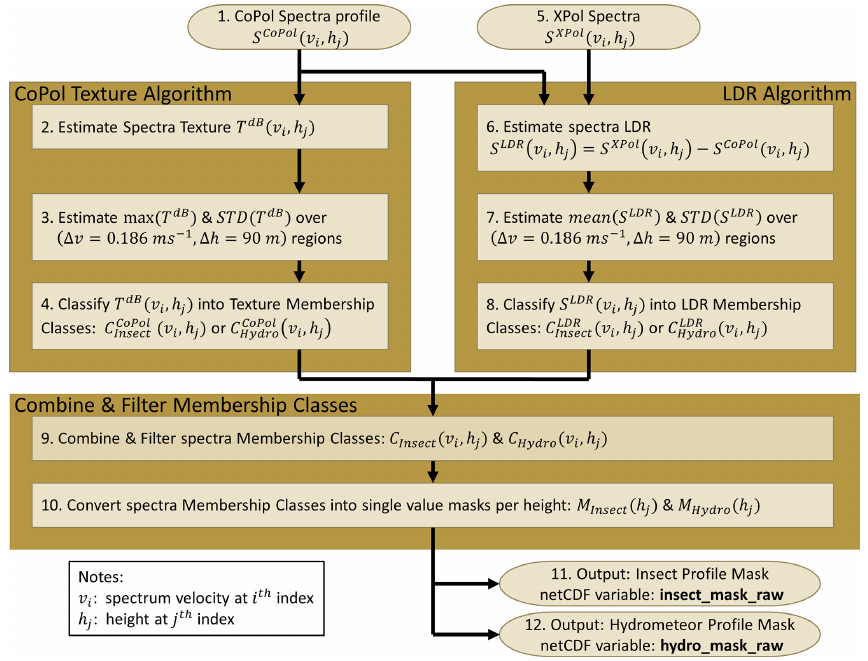
Figure 5. Retrieval logical flow